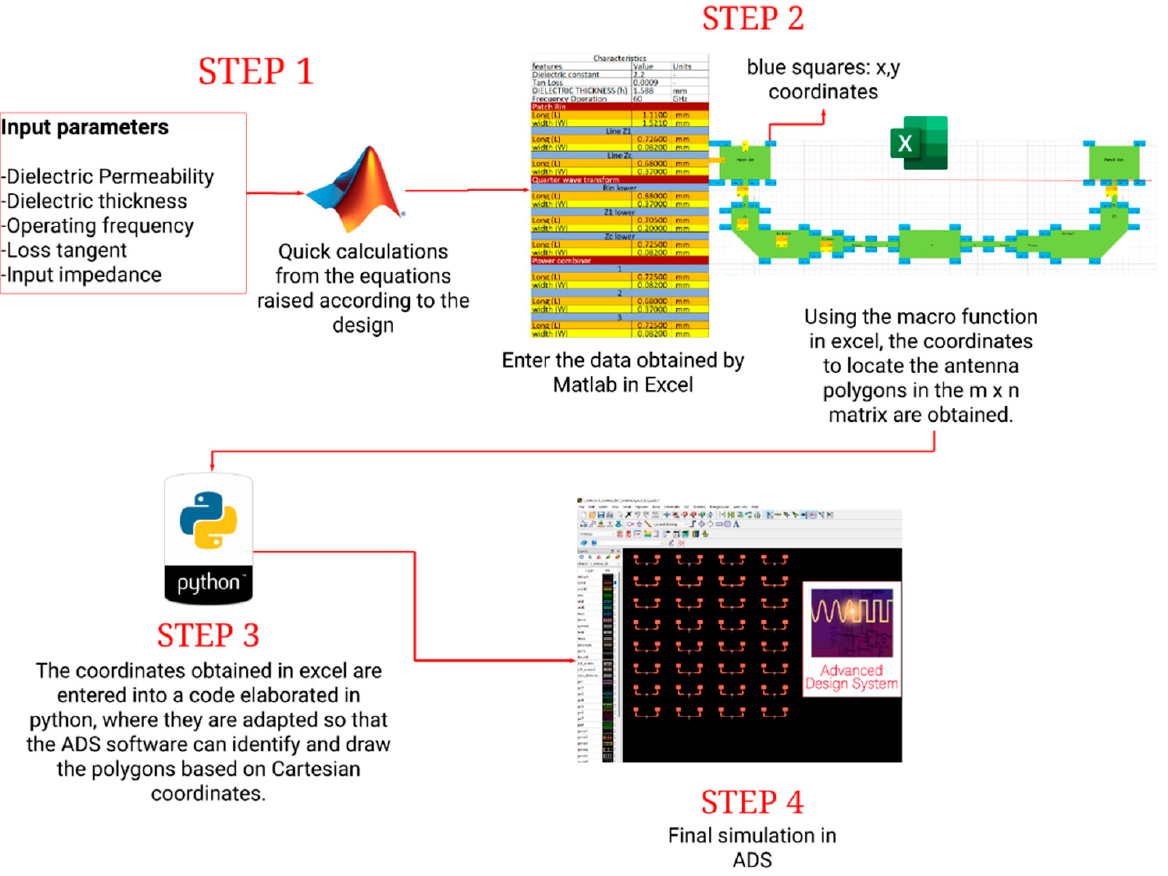
Figure 8. Steps for the development of automatized antenna arrays.